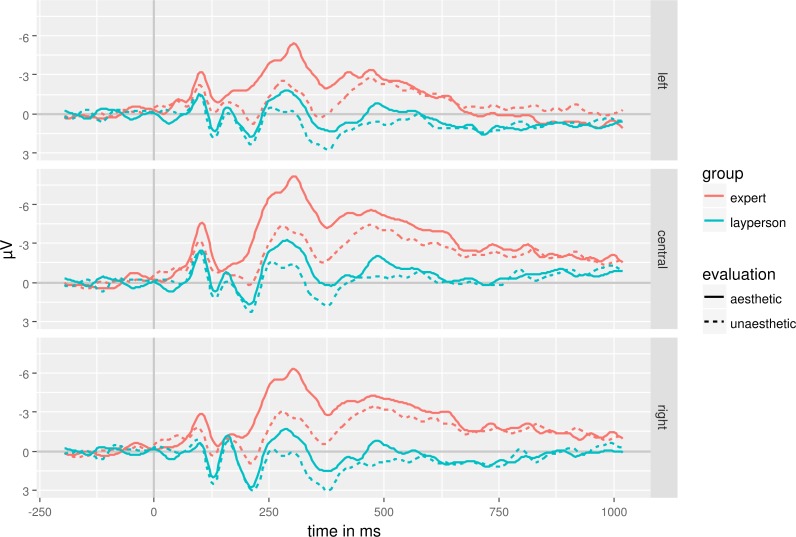
EEG-signal as a function of expertise, aesthetics and left–right regions of interests.